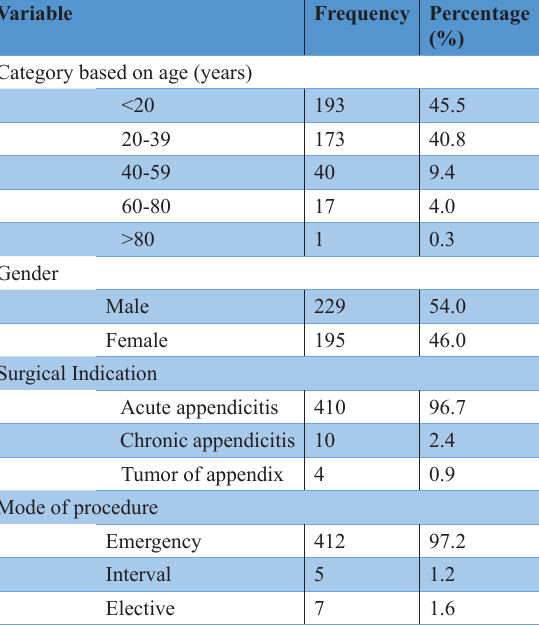
Table 1. Sociodemographic and clinical characteristics of the study population (n